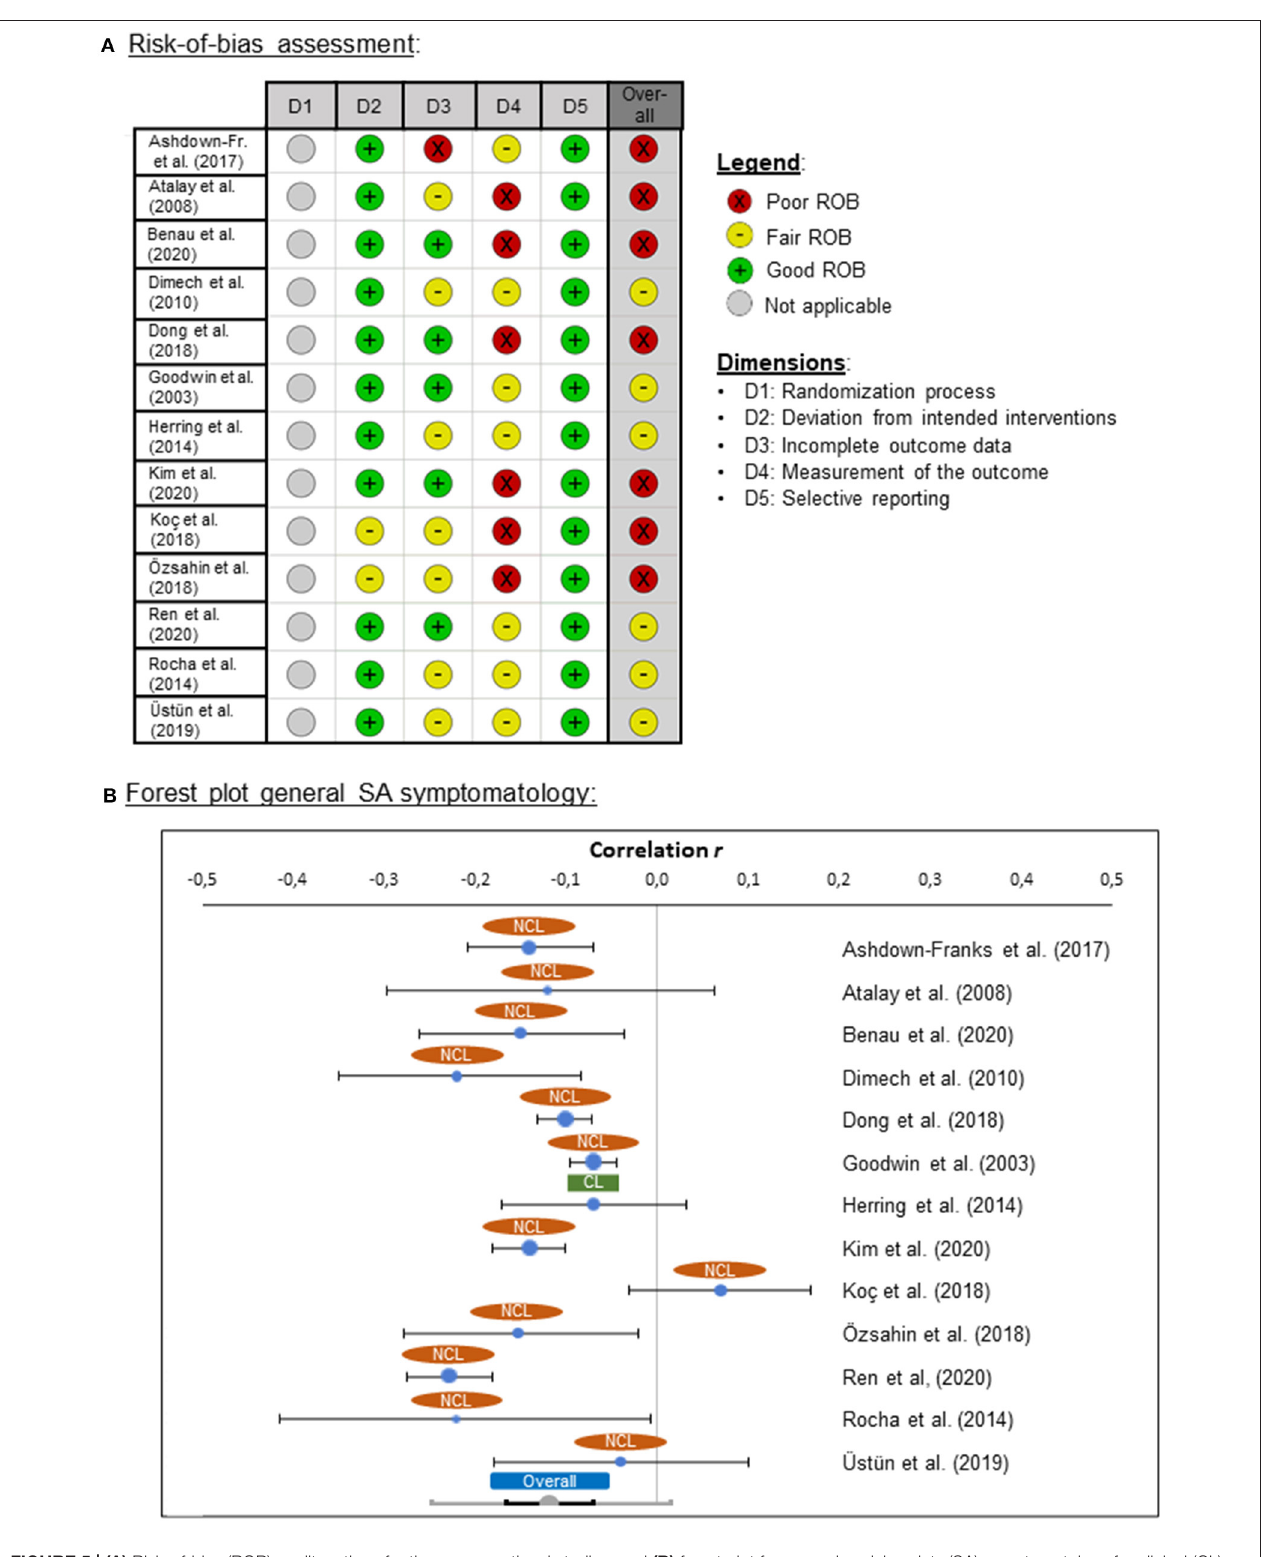
FIGURE 5 | (A) Risk-of-bias (ROB) quality ratings for the cross-sectional studies, and (B) forest plot for general social anxiety (SA) symptomatology for clinical (CL) and non-clinical (NCL) samples. ROB was assessed by means of the “Quality Assessment Tool for Observational Cohort and Cross-Sectional Studies” from the National Heart, Lung, and Blood Institute (2019). Negative effect sizes indicate that higher levels of PA were associated with lower levels of SA.